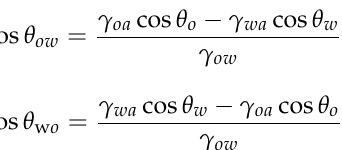
Figure 4. Successive frames of ( a ) the oil sliding tested in water environment and ( b ) water wetting test in oil environment on the CTS-coated cotton. Dichloroethane was selected as the test oil. ( c ) The mechanism of the underoil superhydrophilicity and underwater superoleophobicity.